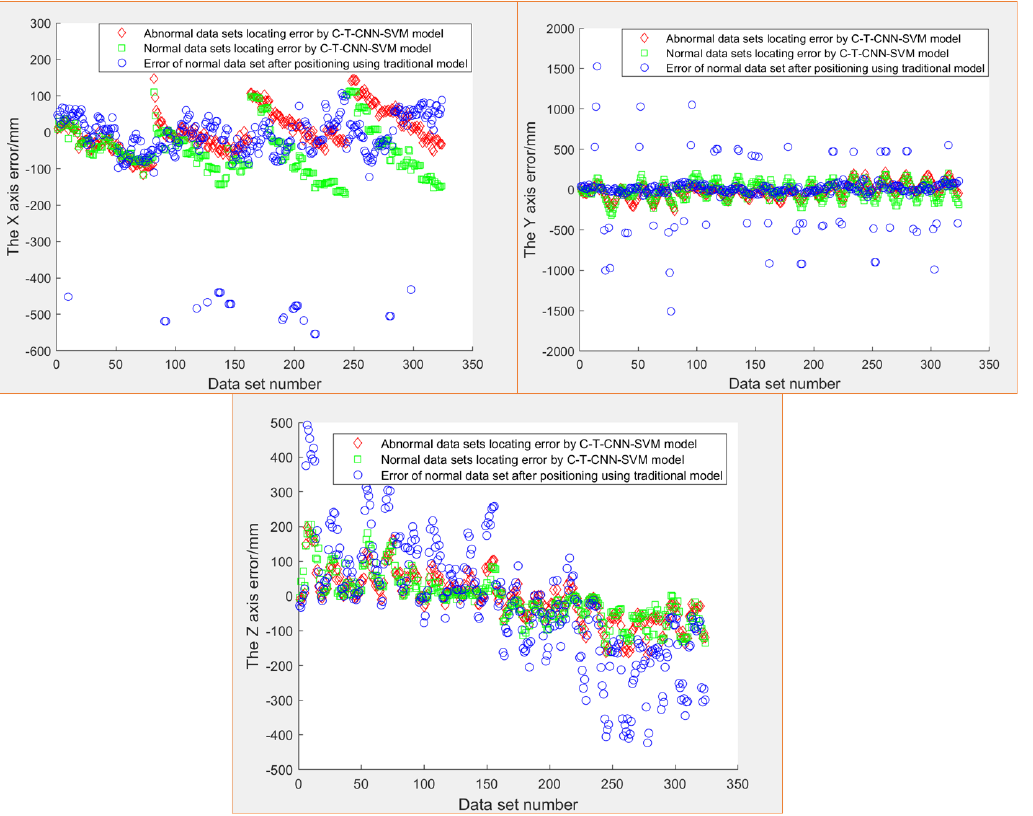
Figure 10. 1D accuracy of abnormal data sets based on C-T-CNN-SVM algorithm.